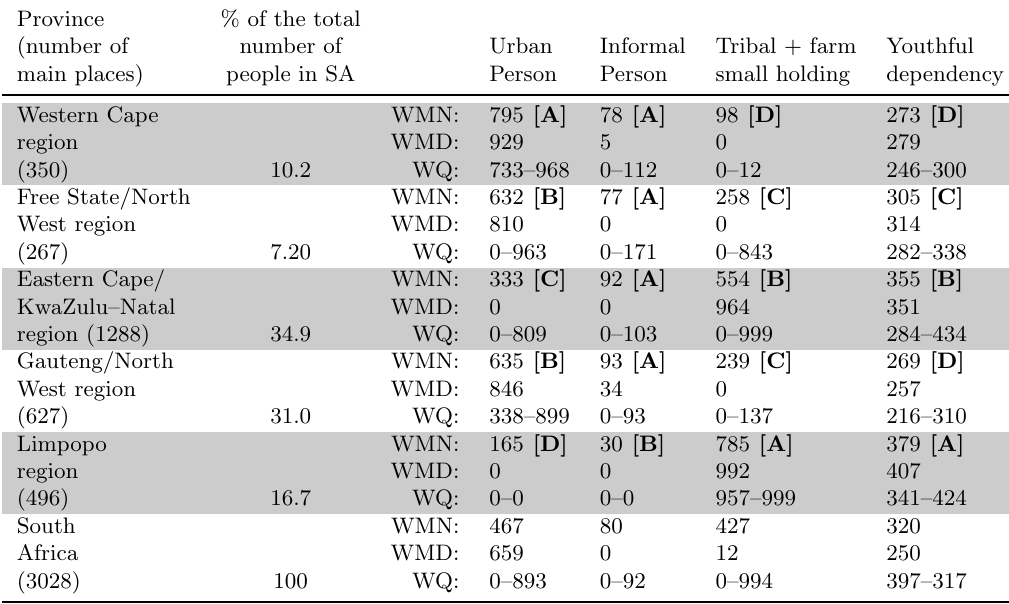
Comparing the five intramax regions with respect to area of residence and youth- ful dependency per 1 000 persons. [A] to [D]: different symbols indicate which means of these variables (comparing different regions in descending order from [A] to [D]) are significantly differ- ent, Bonferroni multiple comparison test, p < 0 . 05 . The following abbreviations are used: WMN for weighted mean per 1 000 persons, WMD for weighted median per 1 000 persons and WQ for weighted inter-quartile range per 1 000